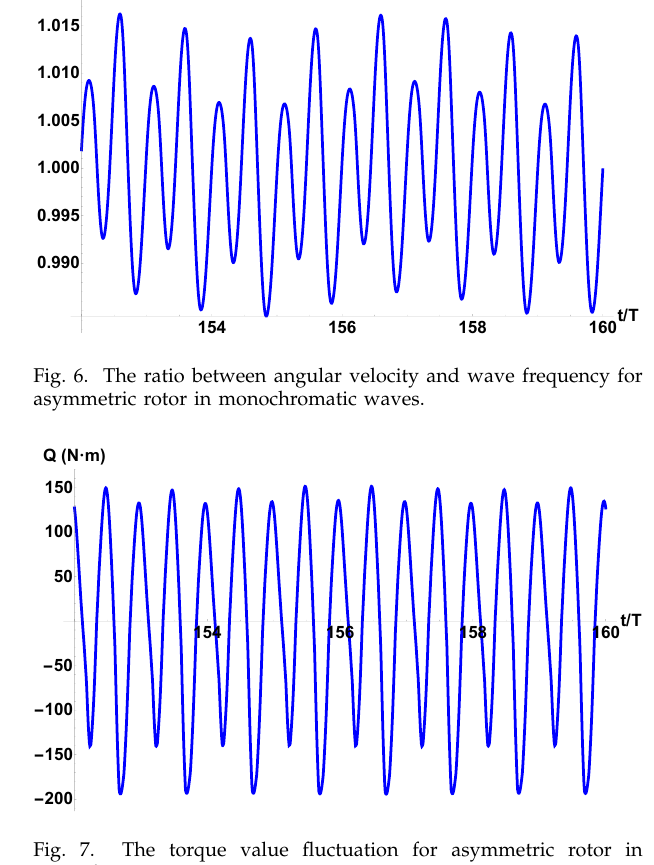
Fig. 7. The torque value fluctuation for asymmetric rotor in monochromatic